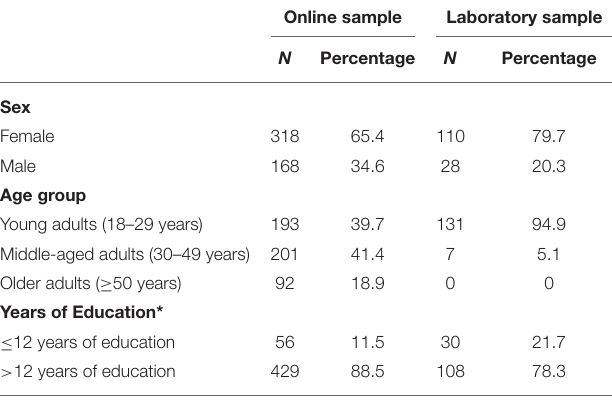
TABLE 1 | Characterization of the sample regarding sex, age group, and years of education.